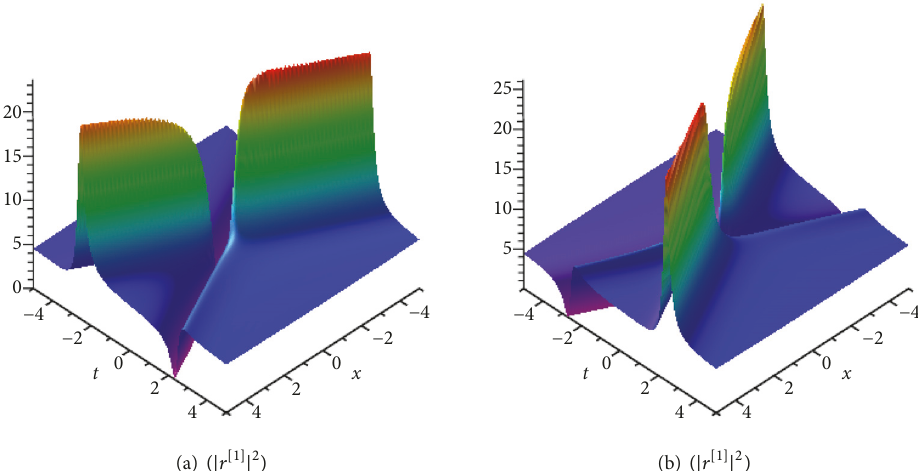
Figure 3: |𝑟 [1] | 2 displays two structures with the height of background being 5. (a) The bright-bright 1 structure: (𝐽 1 , 𝐽 2 ) = (0.2,−0.1) . (b) The bright-bright 2 structure: (𝐽 1 ,𝐽 2 ) = (3,−1)